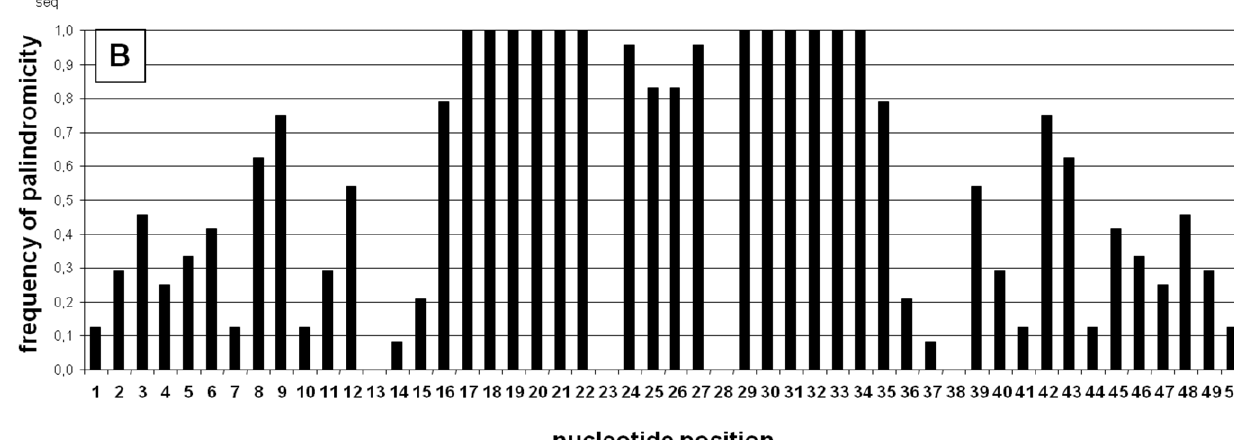
(Figure 6D). The D recA D recG or D ruvC D recG double and D xerH D ruvC D recG triple deletion strains had the same phenotype as D recA or D ruvC single deletion strains (data not shown). Two failed attempts to obtain a D recA derivative of a D xerH strain prevented assessment of UV sensitivity in the absence of both xerH and